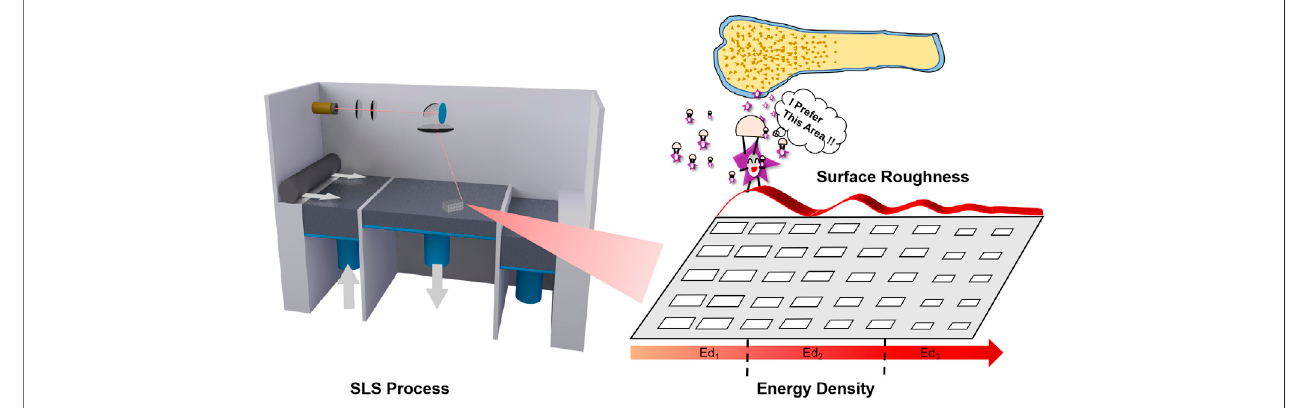
FIGURE 1 | The Schematic diagram of this work.